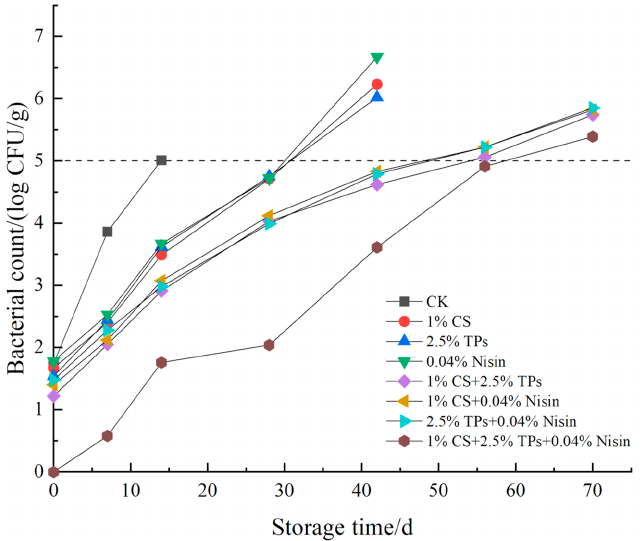
Figure 7. Effects of the compound preservatives on the total bacterial count of plant-based meat. CFU, colony-forming units; CS, chitosan; TP, tea polyphenols; CK, control group.